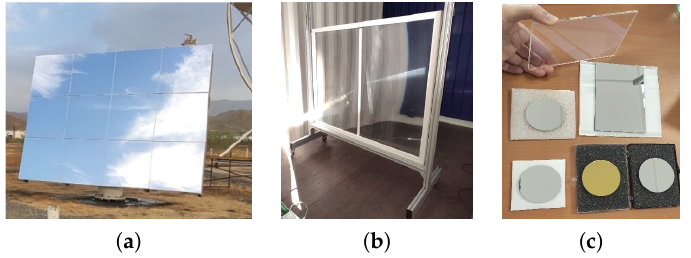
Figure 3. ( a ) Heliostat, ( b ) Fresnel lens and ( c ) selective reflectance mirrors used in the solar